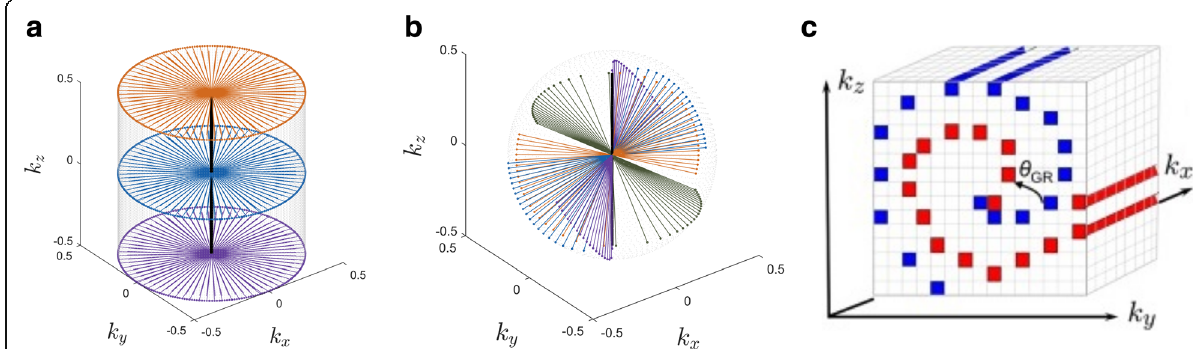
Fig. 2 Examples of radial 3D k-space sampling schemes. a Stack-of-stars (SoS). b Spiral phyllotaxis. c Golden angle Cartesian acquisition with Spiral Profile ordering (G-CASPR)